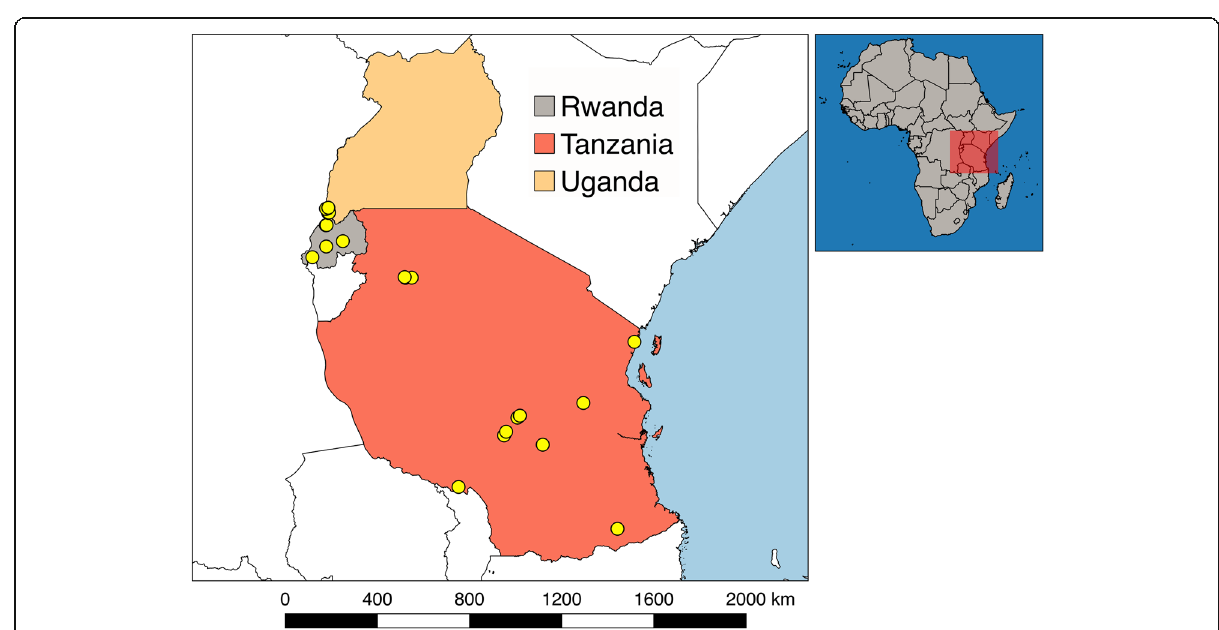
Fig. 1 Unique locations where samples from bats were